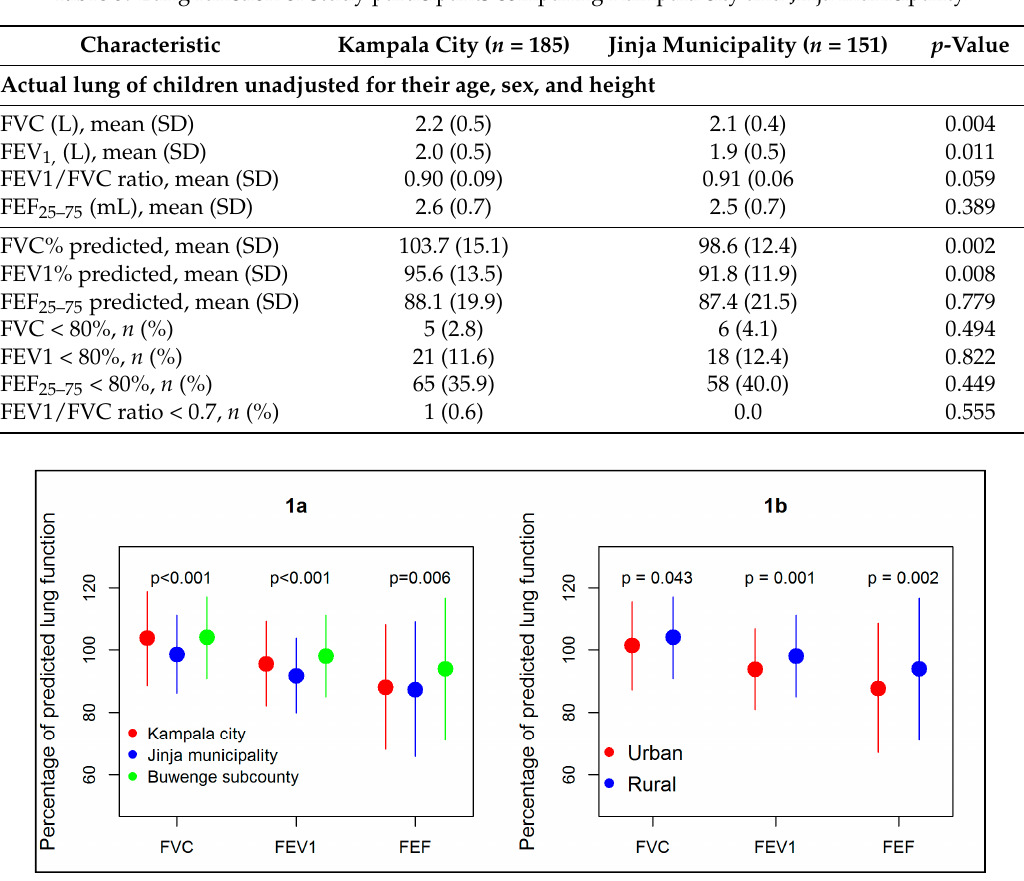
Figure 1. Mean distribution of spirometry parameters (percentage of predicted lung function) by site ( 1a ) and ( 1b ). By urban status ( 1b ). Circles show mean levels and bars show standard deviation. FVC = forced vital capacity, FEVI = forced expiratory volume in one second and FEF = forced expiratory flow 25–75%.